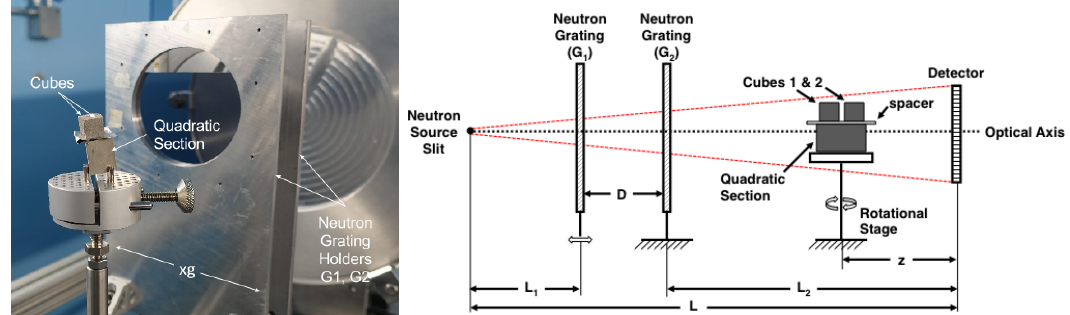
Figure 2. Optical photograph ( left ) and sketch ( right ) of the experimental setup. The view on the left is looking upstream towards the neutron source; the milled disk is the end of an evacuated flight tube. Out of view to the left are the scintillator and camera. The sample is mounted 5 cm downstream of the G2 phase grating. The G1 phase grating is moved relative to G2 so as to tune the interferometry autocorrelation scattering length, ξ . This G1-G2 distance is referenced in this study as “D”. x g refers to the stepping of the G1 phase grating perpendicular to the beam